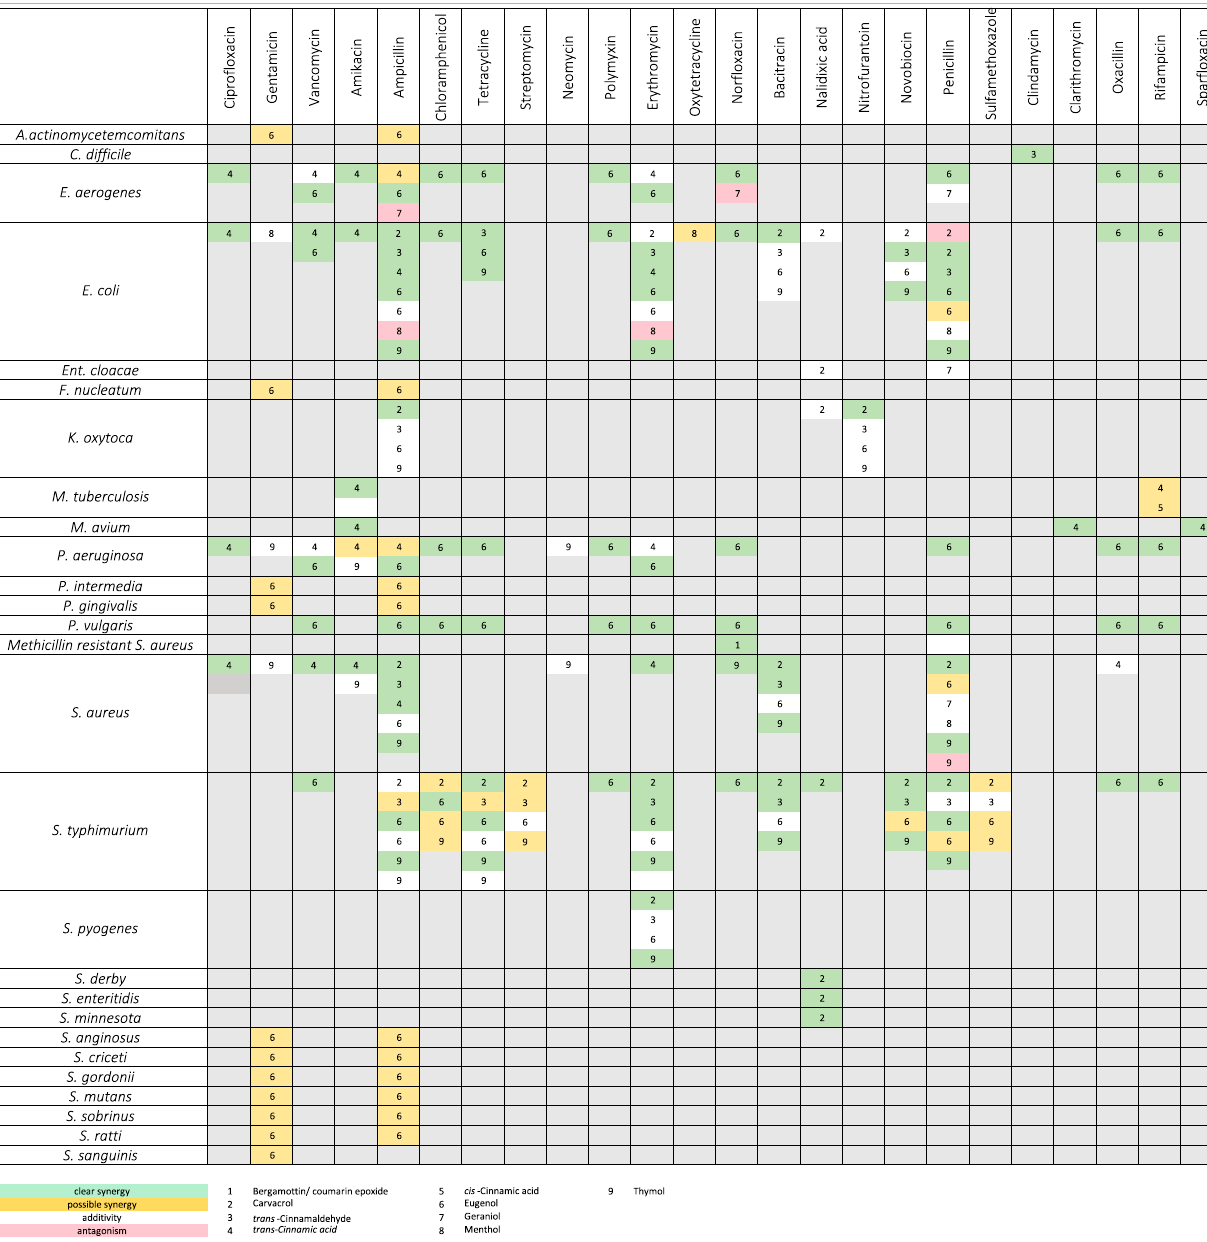
TABLE 2 | In vitro synergistic action between EO constituents and antibiotics. Methods used: Checkerboard assay (isobologram, fractional inhibitory concentration (FIC) index)ortime-killassayorfoldreductioninminimuminhibitoryconcentration(MIC)orchangeininhibitionzoneinthepresenceofEOvapor.[Adaptedandcompiledfrom Langeveld et al.